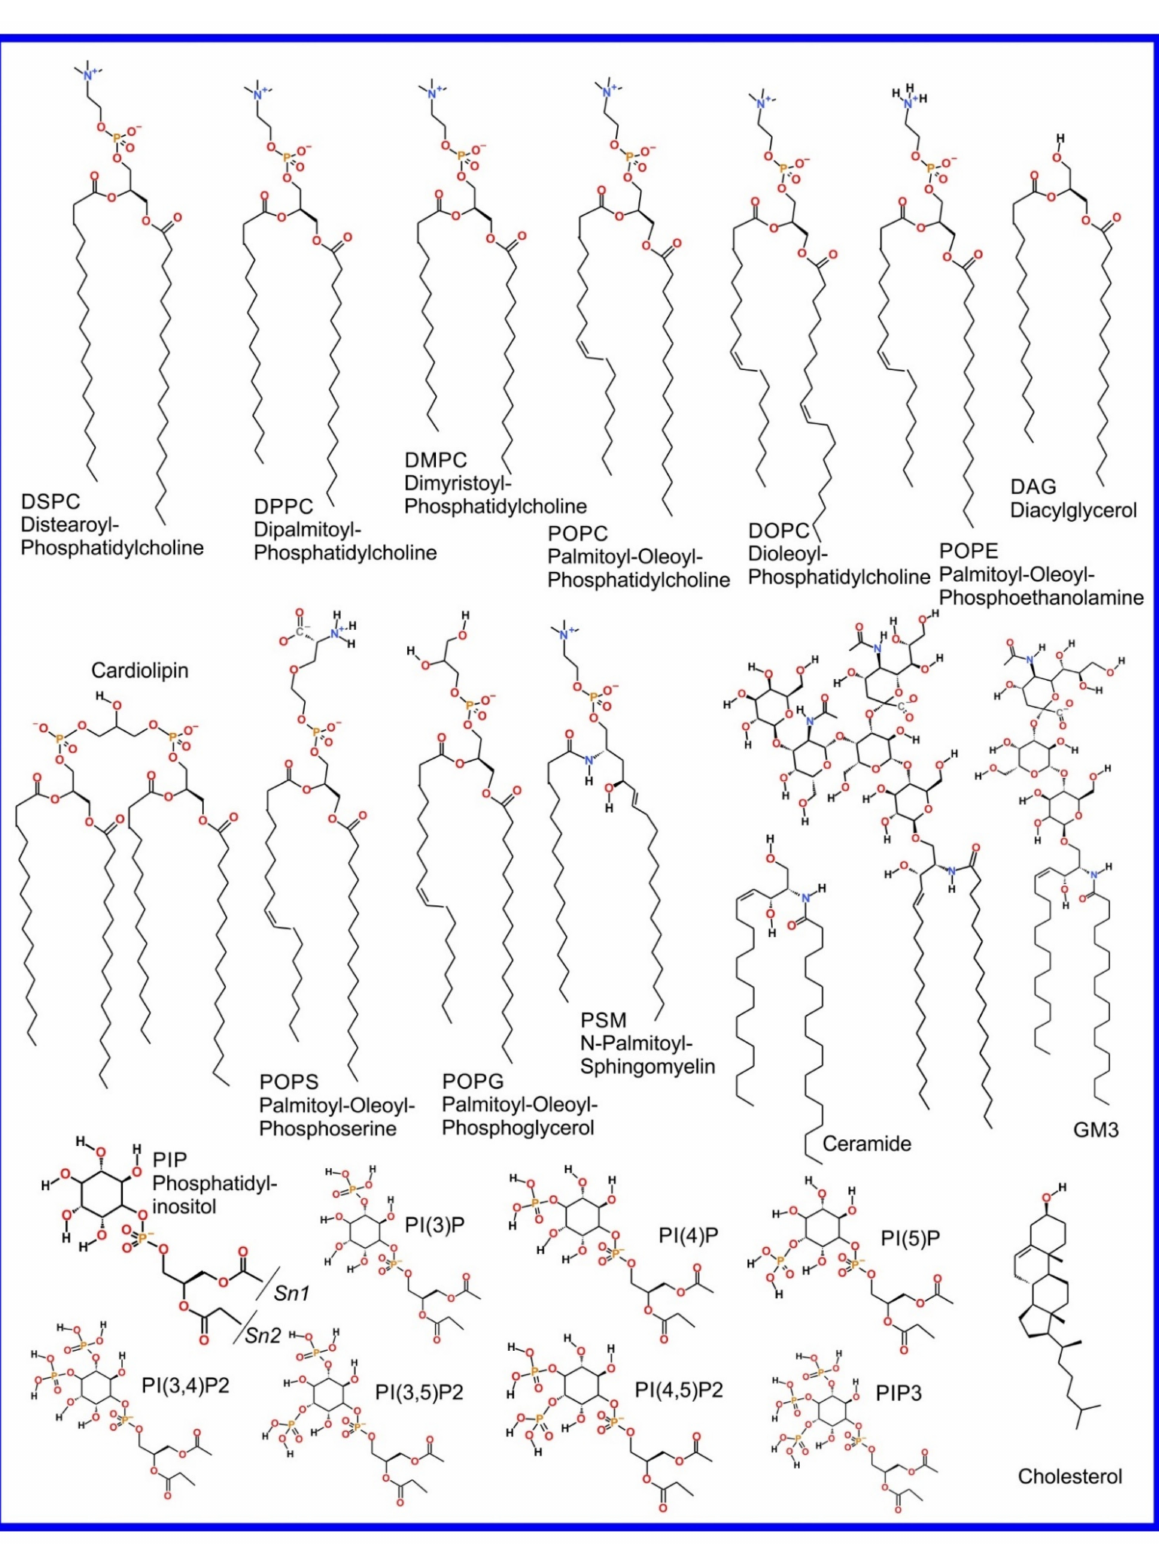
Figure 1. Chemical structure of lipids mentioned in this